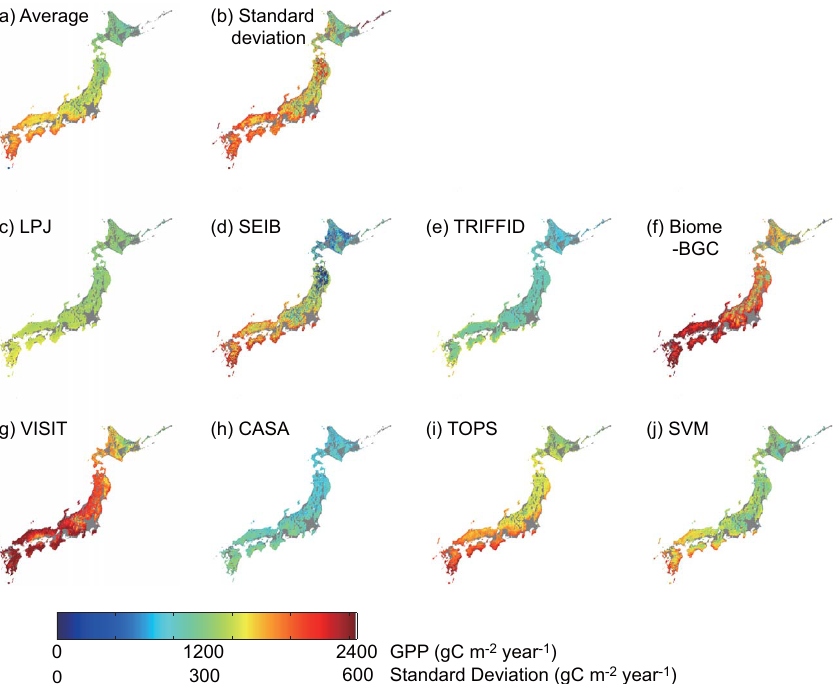
Fig. 7. Average (a) and standard deviations (b) of annual total GPP for eight models and for each model (c)–(j) . GPP from 2001–2006 were used to calculate the annual total.